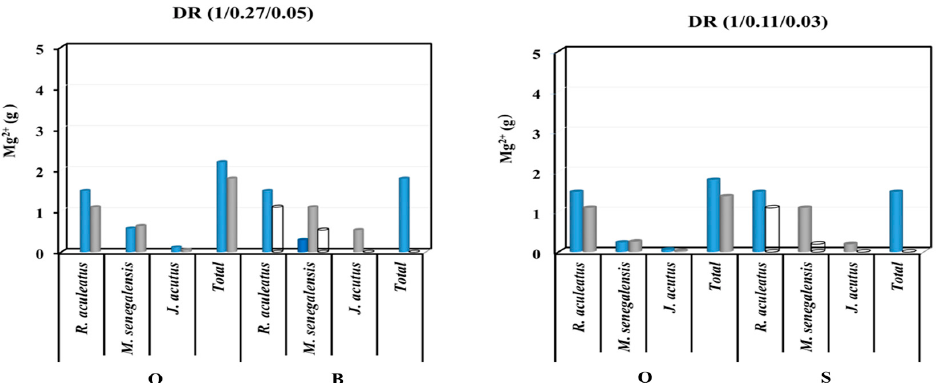
Figure 3. Cation loads of each water treatment for their respective distribution ratio itemized by species and the total (DR, distribution of the number plants of the three species that can be grown in each water system). O—open system, B—blended water system, and S—sequential reuse water system.